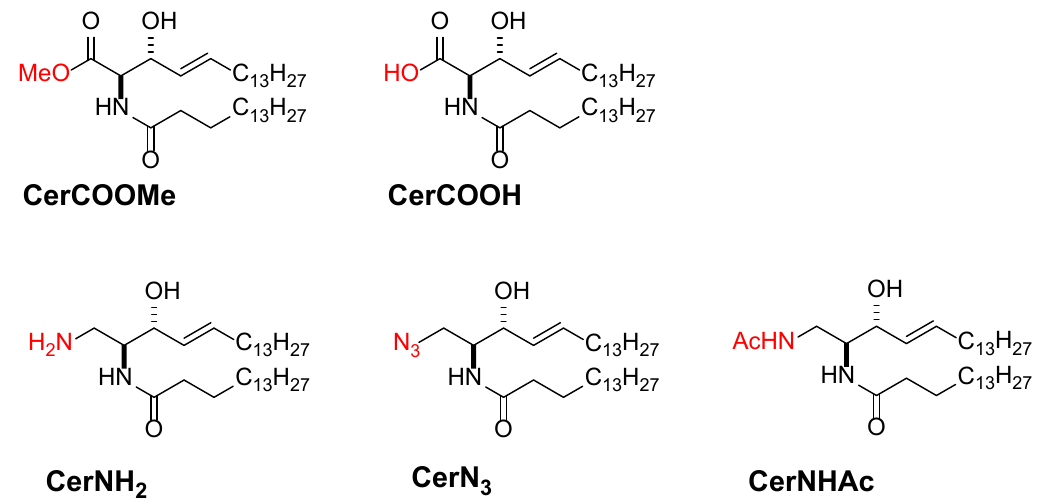
Figure 6. Chemical structures of 1-OH group substituted ceramide analogues developed in [102,103]. Protective groups are indicated by red colour.